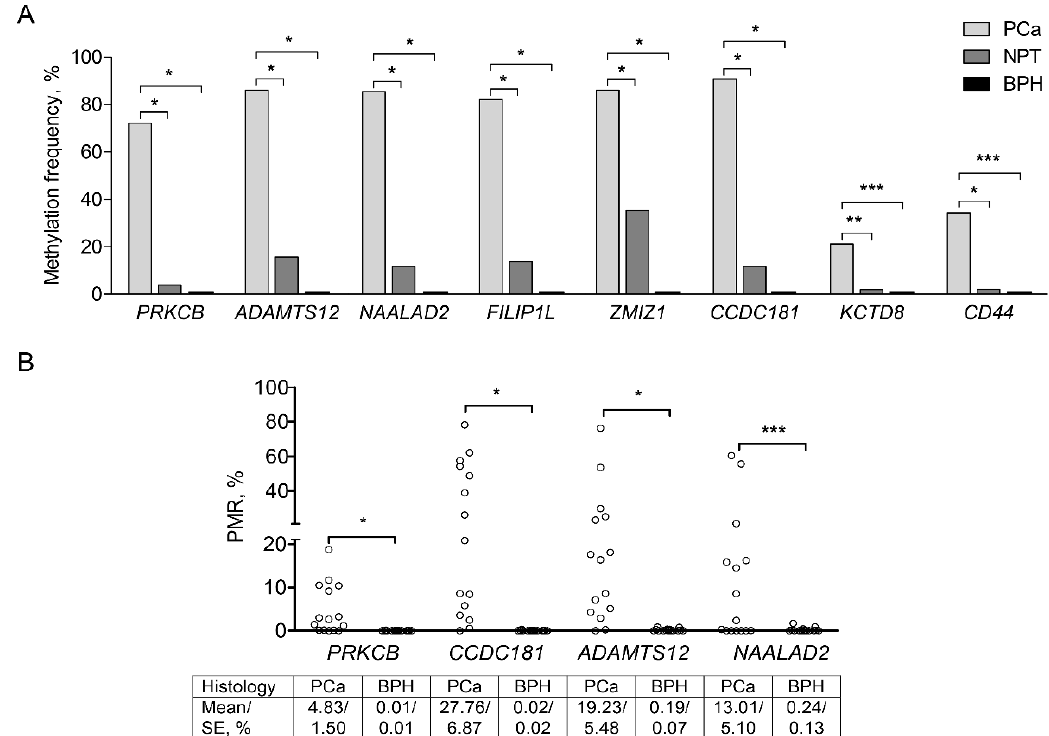
Figure 2. Promoter methylation analysis of the selected target genes in prostate tissue samples. ( A ) Promoter methylation frequencies of the analyzed genes (MSP data); ( B ) Methylation intensity values as a percentage of methylated reference (PMR) of genes PRKCB , CCDC181 , ADAMTS12 , and NAALAD2 (QMSP data). Mean PMR values with standard error of the mean (SE) are given below for each group. PCa—prostate cancer, NPT—noncancerous prostate tissue, BPH—benign prostatic hyperplasia. Statistically significant p -values are marked in bold. *— p ≤ 0.0001, **— p < 0.001, ***— p < 0.05.